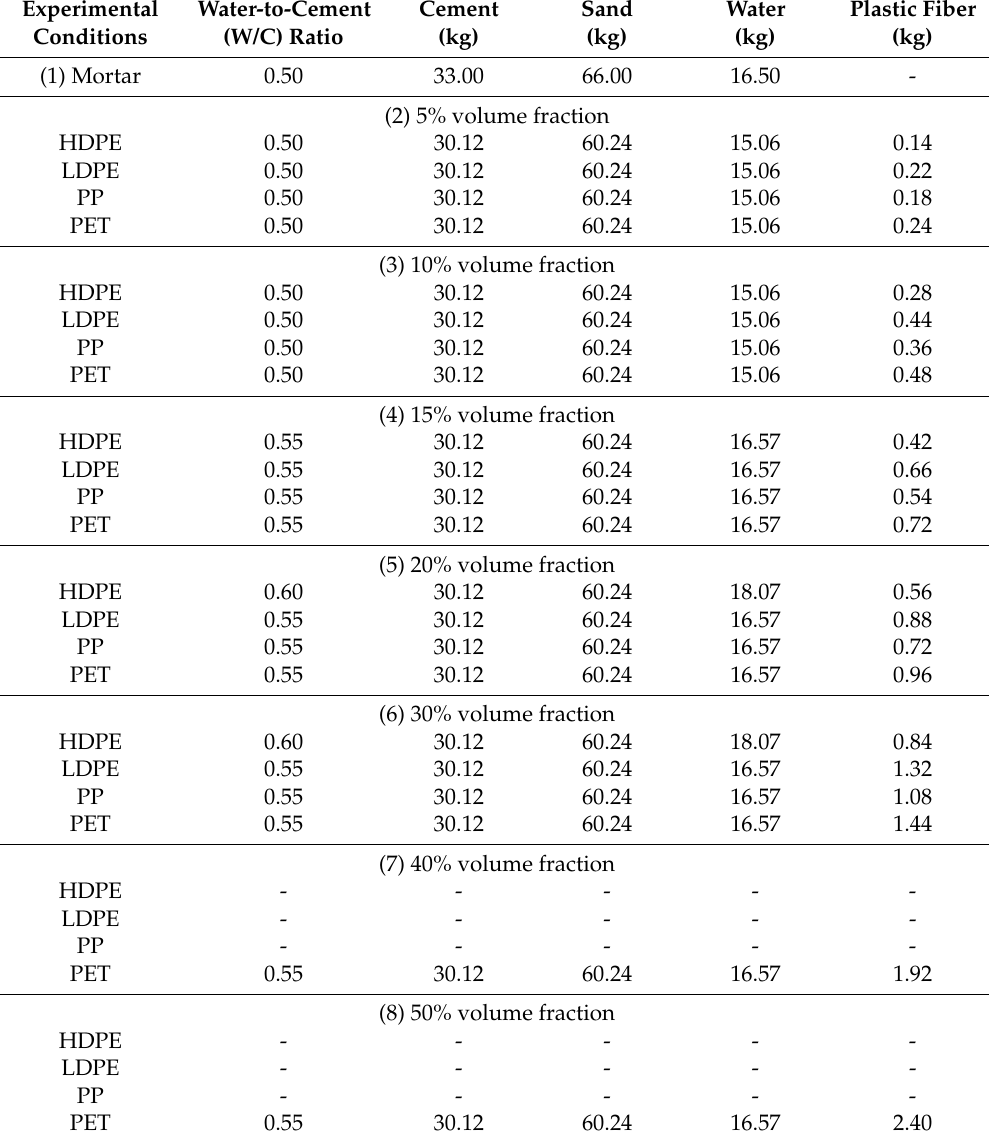
Table 1. Conditions of concrete processing from various plastic wastes.